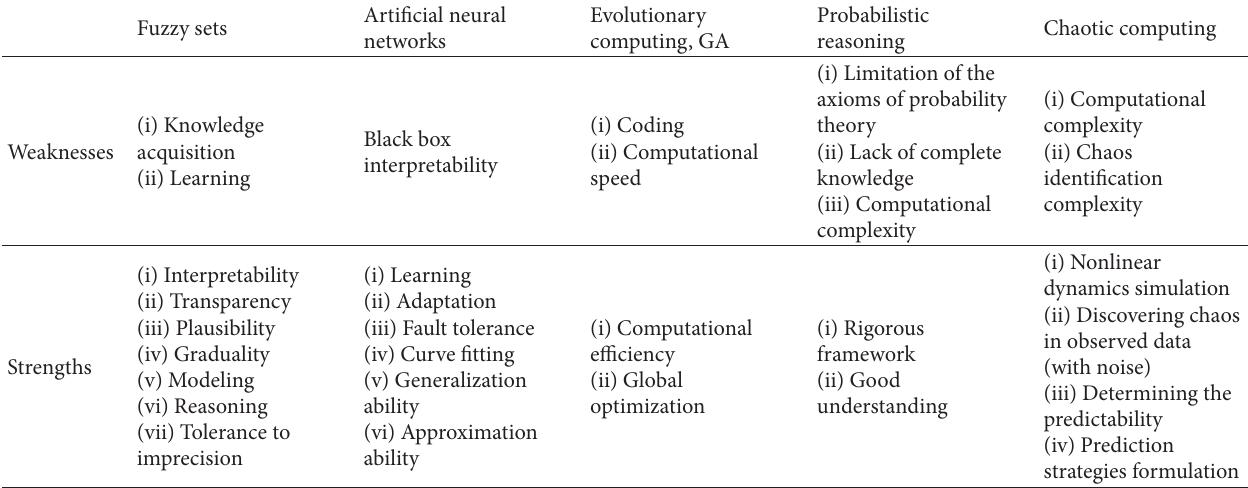
Table 1: Central characteristics of soft computing